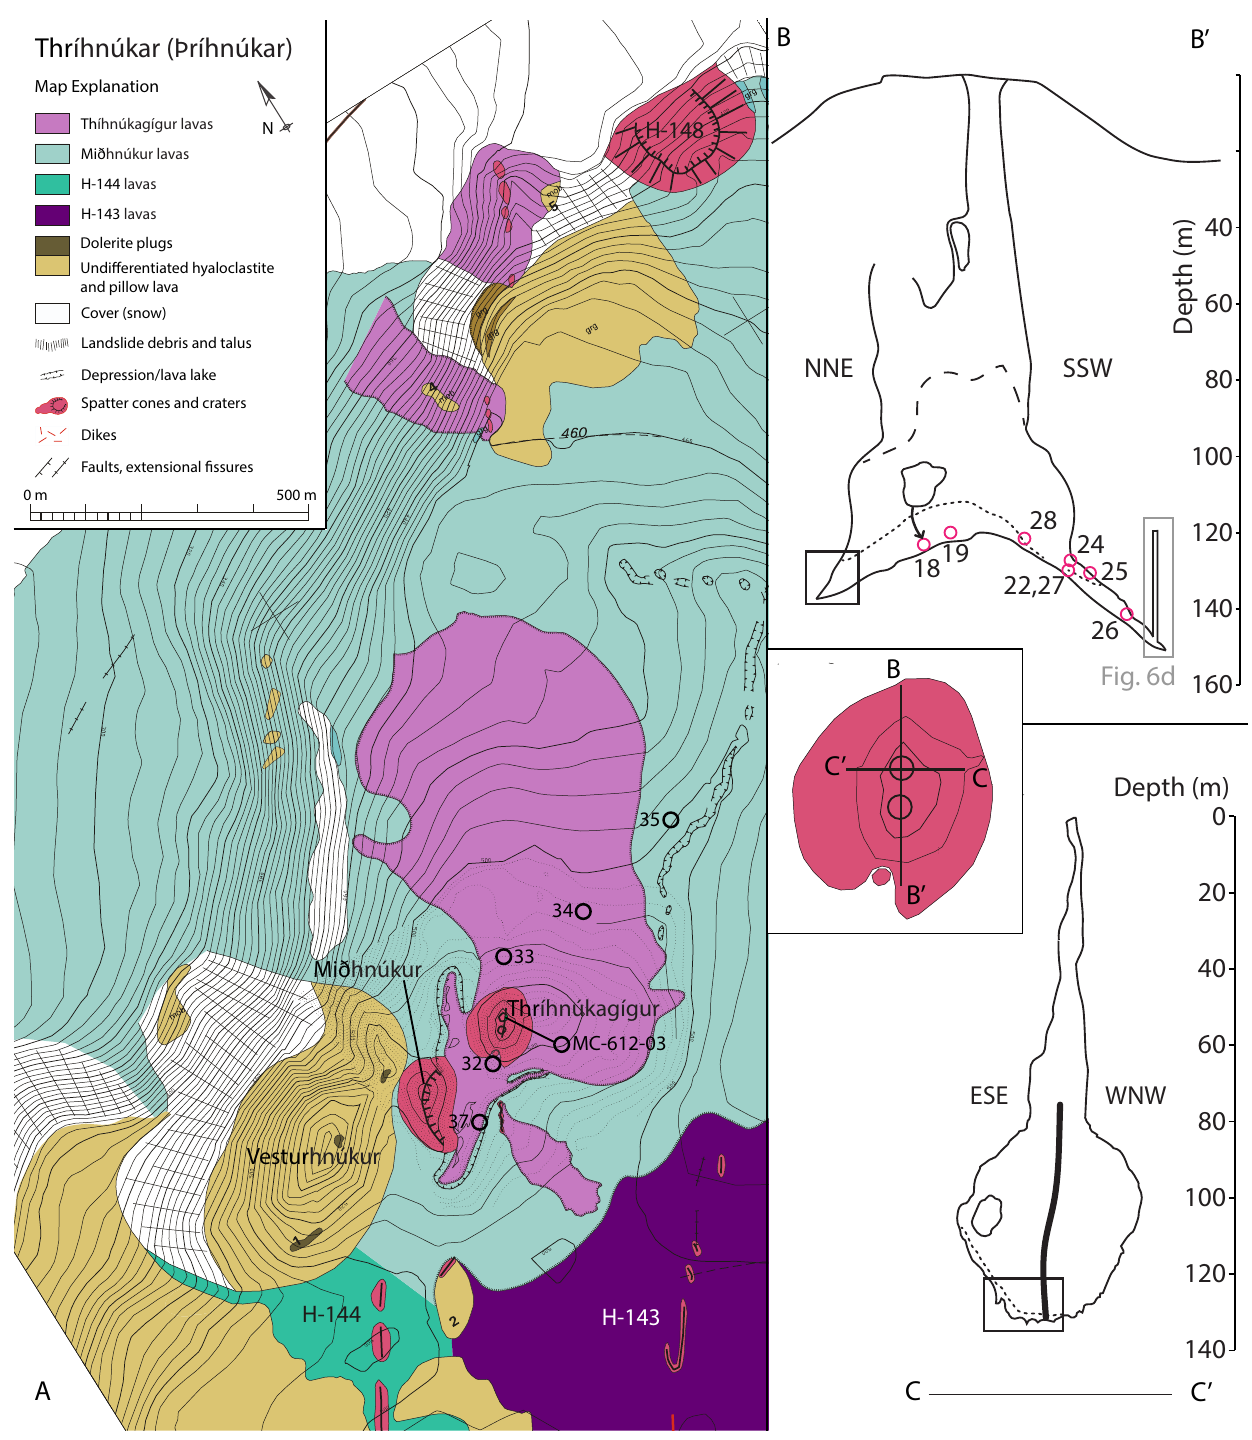
Figure 3: Map of the Thríhnúkar fissure system [A] modified from Sæmundsson [2006]. Erupted sample locations are shown in black circles. An enlarged inset of Thríhnúkagígur spatter cone shows the location of cross-sectional profiles of the cave below traced from LiDAR scans [LaFemina and Normandeau 2016; Zhao et al. 2019] both within the plane of the dike [B] and perpendicular to the dike [C]. Intrusive samples and samples of the tephra are shown with pink circles. The dotted line [B] represents the contact with the tephra. The dashed line [B] represents the roof of the cave and the uppermost extent of rock fall where the cave transitions into the narrower original conduit [C]. The small vertical pipe represents a proto-conduit (see Figure 6C, D). The boxes are illustrated in greater detail in Figure 4 with additional dike and buried tephra with sample